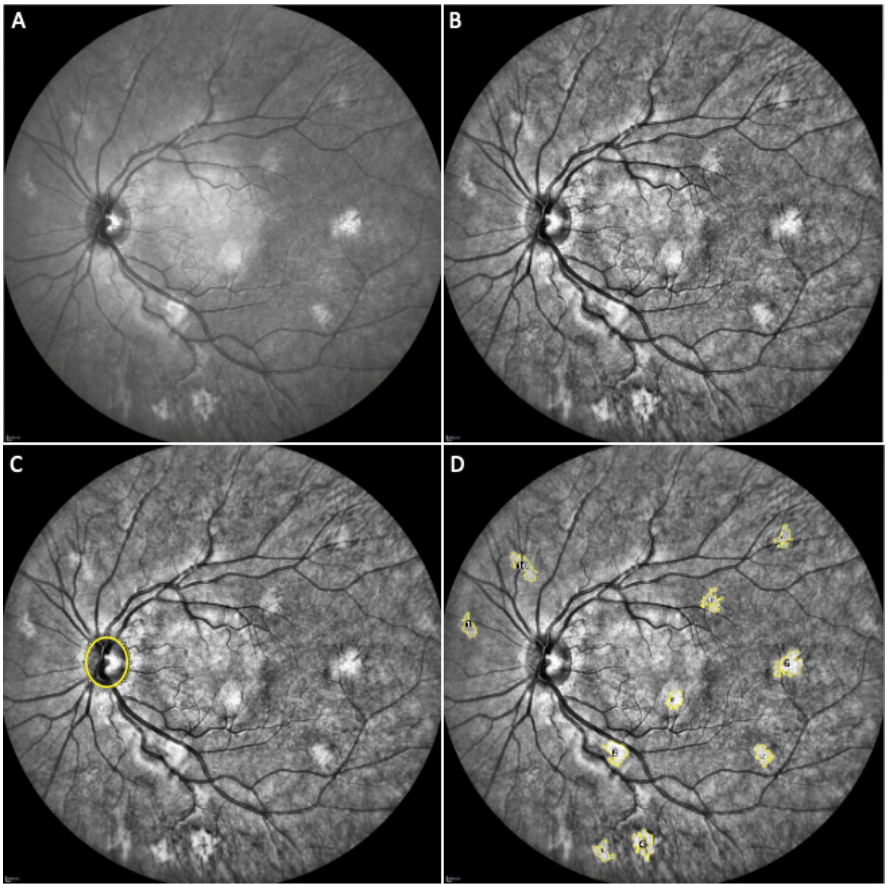
Figure 1. Elaboration of a near-infrared (NIR) image of a neurofibromatosis type 1 (NF1) patient eye with choroidal abnormalities (CAs). ( A ) original NIR image; ( B ) application of the “Enhance Local Contrast” tool with software standard parameters; ( C ) identification of the optic disc margin with the “Oval” tool; ( D ) identification of all the visible CAs, tracing of their margin with the “Wand Tracing” tool and assignment of a reference number.